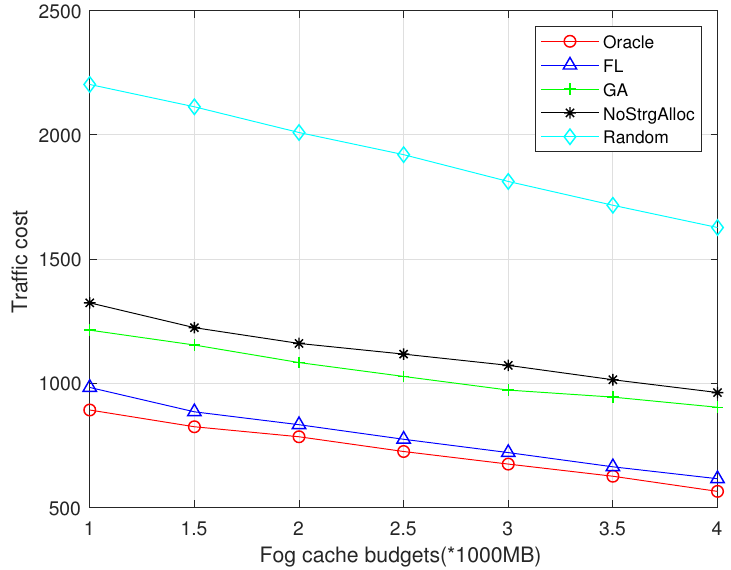
Figure 8. Traffic cost vs Fog cache budgets (MovieLens